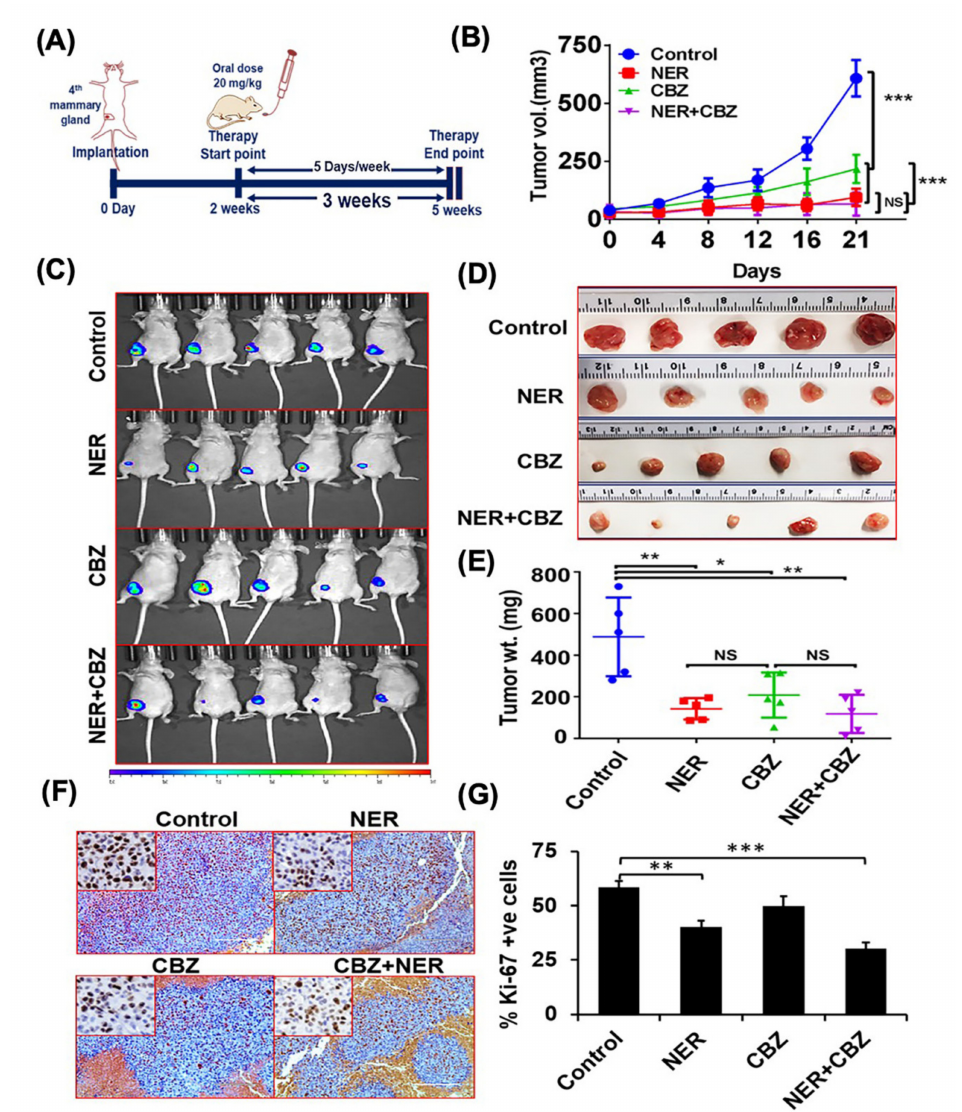
Figure 4. In vivo e ffi cacy of combination treatment against tumor growth in the orthotopic model of metastasis. ( A ) Experimental plan for analyzing the e ffi cacy of NER, CBZ, and their combination in an athymic mouse model of metastasis. ( B ) Tumor growth kinetics ( n = 5 mice / group) after 3 weeks of therapy in di ff erent groups including NER (20 mg / kg / mouse), CBZ (20 mg / kg / mouse), and their combination. ( C ) BLI of mice from each control and treatment groups at the experimental endpoint was performed using the small animal imaging platform. Following live animal imaging, mice were sacrificed, and primary tumors were harvested as photographed ( D ), and weighed for each treatment group ( E ). ( F , G ) SKBrM3 + tumor sections were stained for Ki-67 expression in di ff erent treatment groups to analyze the e ff ect of combination treatment on the percent proliferating cells (Scale bar = 1000 µ m: GraphPad software using one-way ANOVA to compare tumor growth in di ff erent treatment groups with vehicle control (* p < 0.05; ** p < 0.01, *** p < 0.001; NS = No